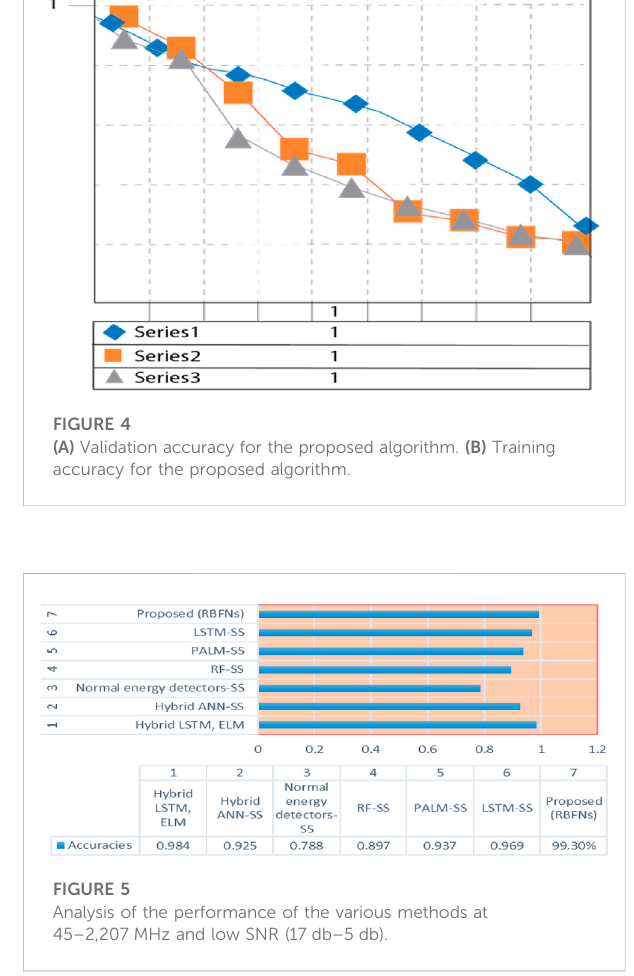
validation of proposed algorithms show better accuracy than existing ones. Figure 3 shows the graphical representation of the analyzed algorithm with different bars.